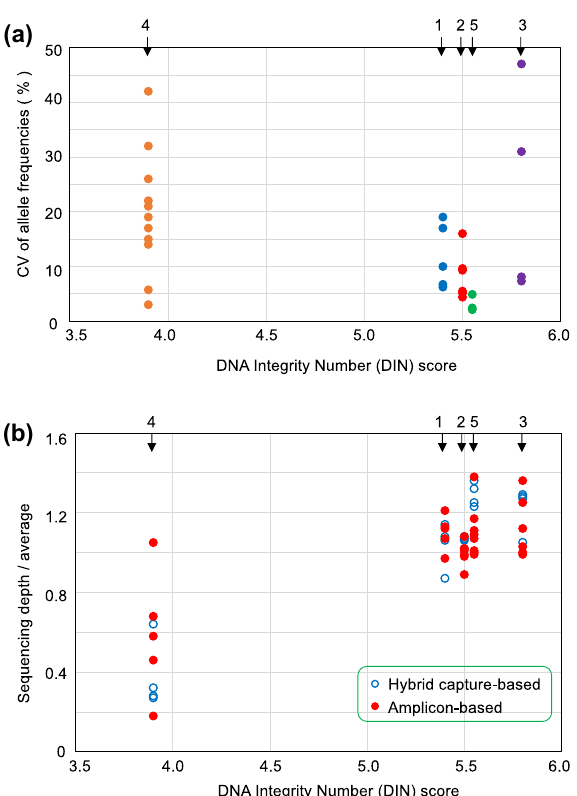
Figure 1. Correlation between DNA quality and NGS results. ( a ) Correlation between DNA quality and coefficient of variation (CV) of allele frequencies for each mutation. Arrows and numbers indicate the patient number. Each circle indicates the CV of allele frequencies of the detected variants. ( b ) Correlation between DNA quality and depth of sequencing coverage for each laboratory. Arrows and numbers indicate the patient number. Open and closed circles indicate the capture-based and amplicon-based methods,